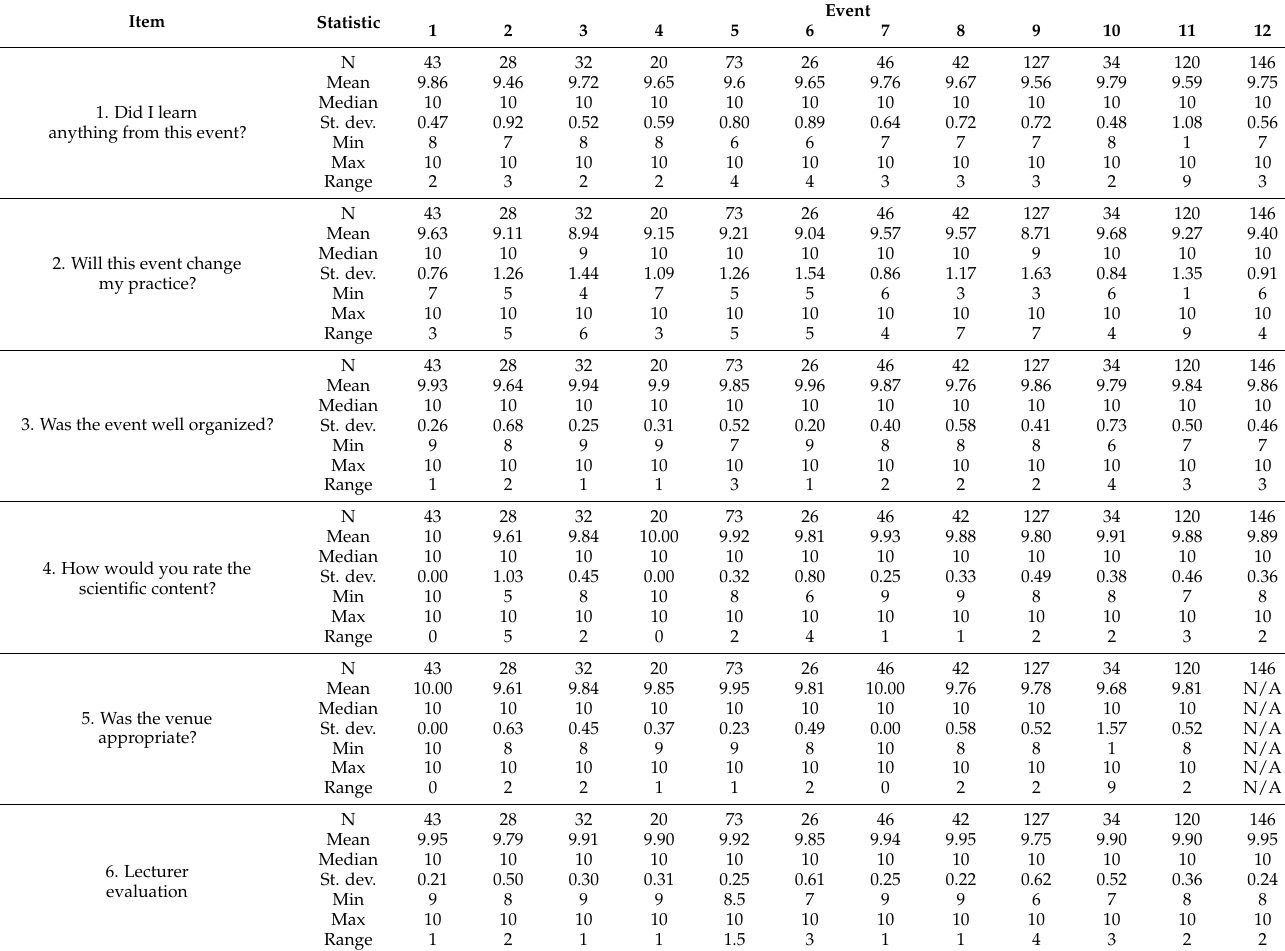
Table 2. Descriptive statistics for the